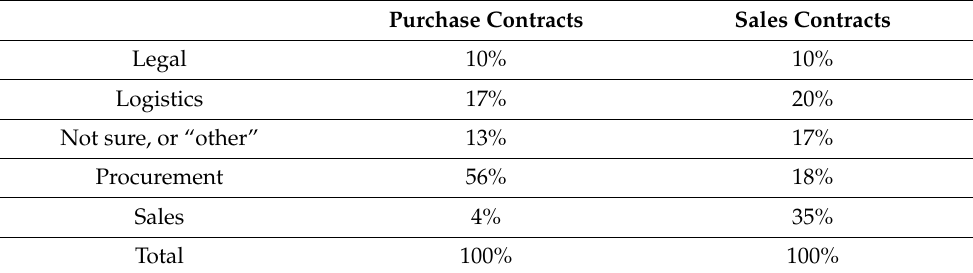
Table A1. Decision Maker for Incoterms ® Choice.